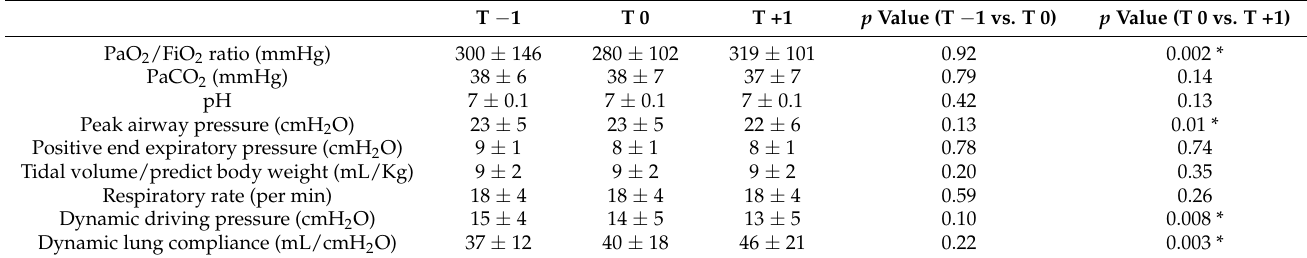
Table 2. Arterial blood gas analyses and respiratory mechanics before and after ultrasound-guided pleural effusion drainage. T − 1 T 0 T +1 p Value (T − 1 vs. T 0) p Value (T 0 vs. T +1) PaO 2 /FiO 2 ratio